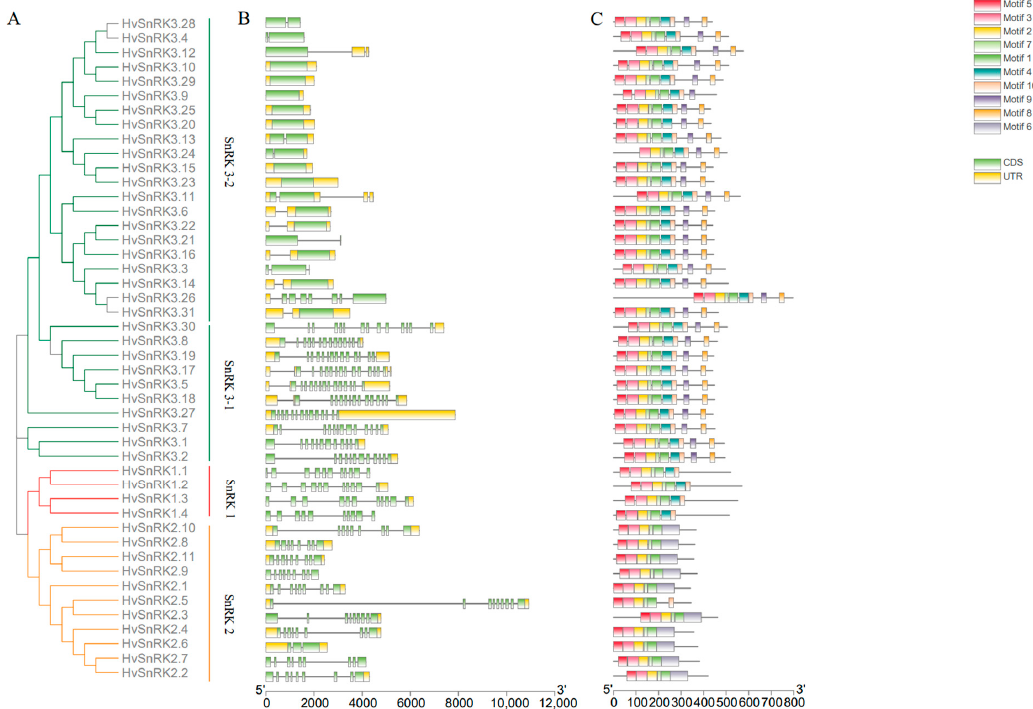
Figure 2. Phylogenetic relationships, gene structures and conserved motifs of the SnRK proteins in H. vulgare : ( A ) Phylogenetic tree of 46 HvSnRK proteins; ( B ) Gene structures of HvSnRK genes. Green boxes: exons. Black lines: introns. Yellow boxes: UTR areas; ( C ) The motif analysis of HvSnRK proteins. The details of the motifs are provided in Table